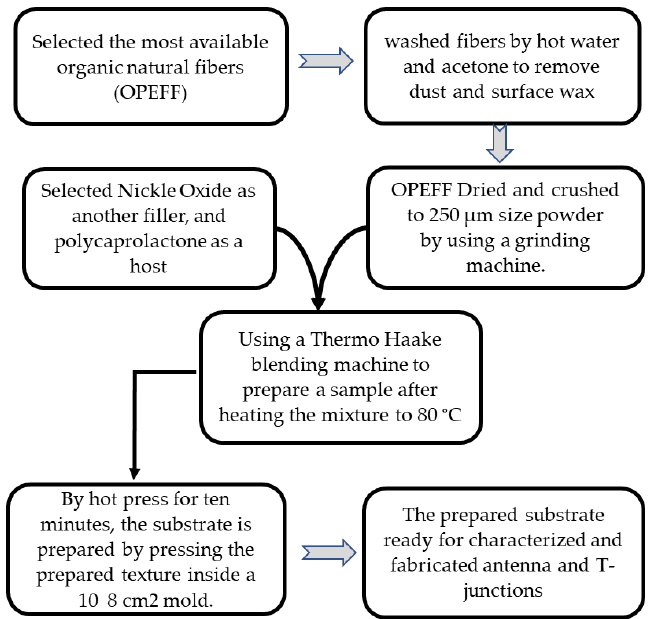
Figure 1. The substrates preparation procedures.